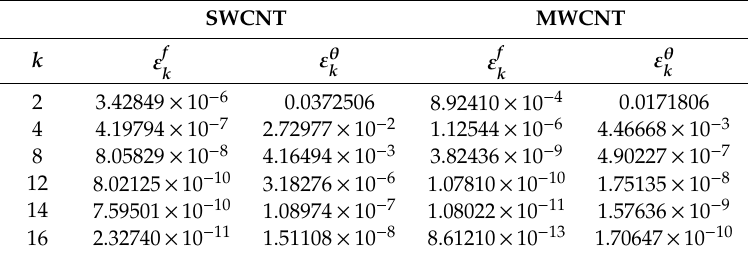
Table 2. Mean square residual errors.